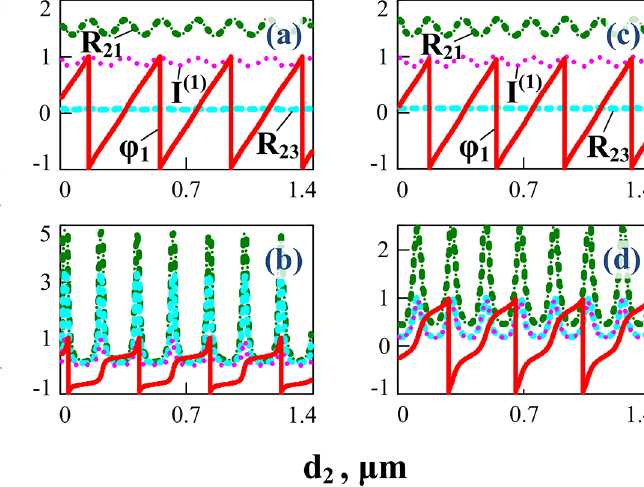
Fig. 9. Dependences of quantities ’ 1 , R 21 , R 23 , I (1) on the main layer thickness d 2 for various materials of layers 1, 3. The values of parameters are: e 1 = e 3 = 2+ 10 (cid:1) 3 i (a, c), 0.01+ 0.01 i (b), (cid:1) 13+ 0.5 i (d); d l =0.63 m m 1,3 =250 nm (a, b), 13 nm (c, d); (a, b), 0.6 m m (c, d). Denotations of the curves in Figures b, d are given in Figures a, c. I (1) = I TM (1) ( z = d 1 + 0.5 d 2 ) for all the graphs. Parameter d 2 is used as the abscissa axis for all the graphs.